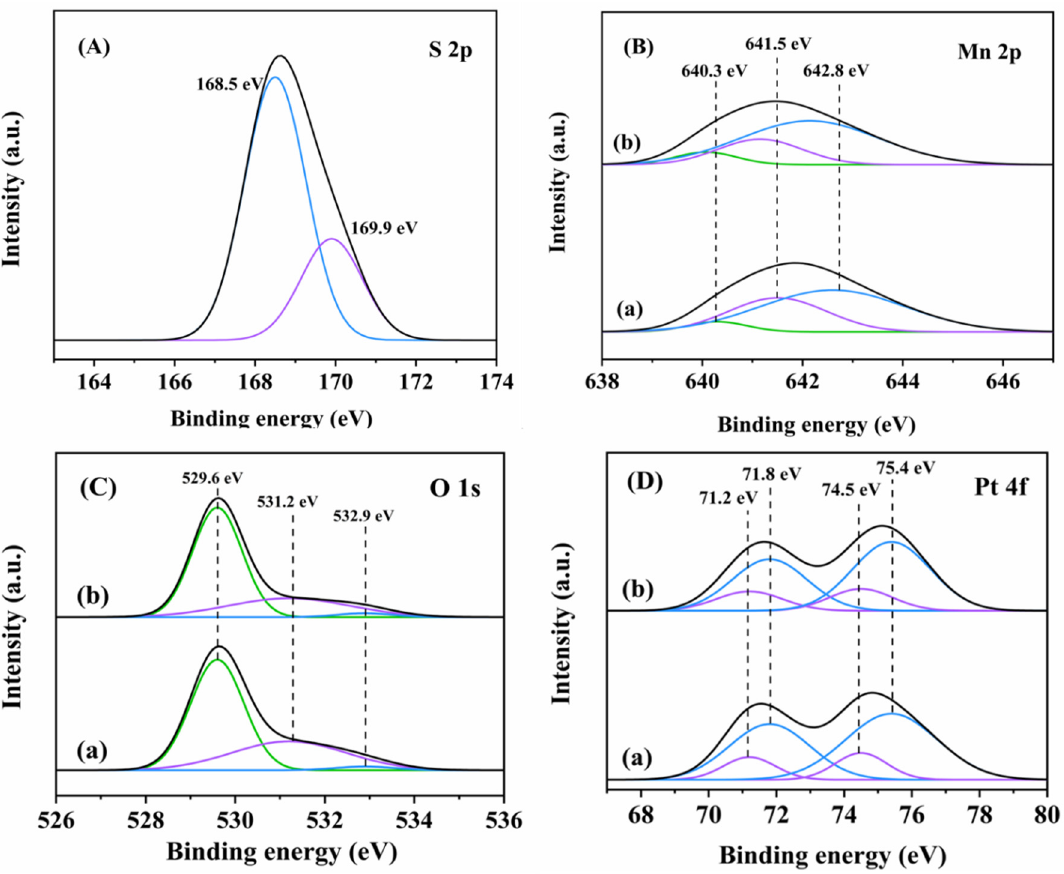
Figure 8. ( A ) S 2p, ( B ) Mn 2p, ( C ) O 1s, and ( D ) Pt 4f XPS spectra of (a) 0.94Pt-1.0rGO/ α -MnO 2 and (b) 0.94Pt-1.0rGO/ α -MnO 2 -S.